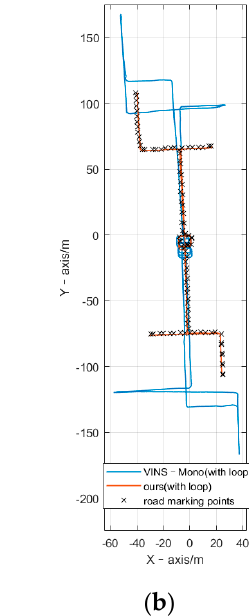
Figure 6. ( a ) Path of floor-scale without loop and ( b ) path of floor-scale with loop. Table 2. Floor-scale pose measurements results.